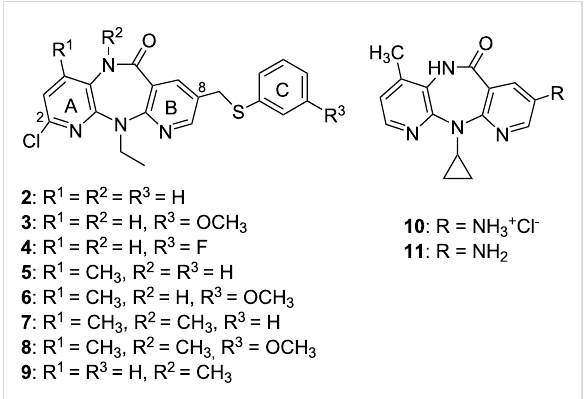
Figure 2: Structures of dipyridodiazepinone derivatives with promising anti-HIV activity.